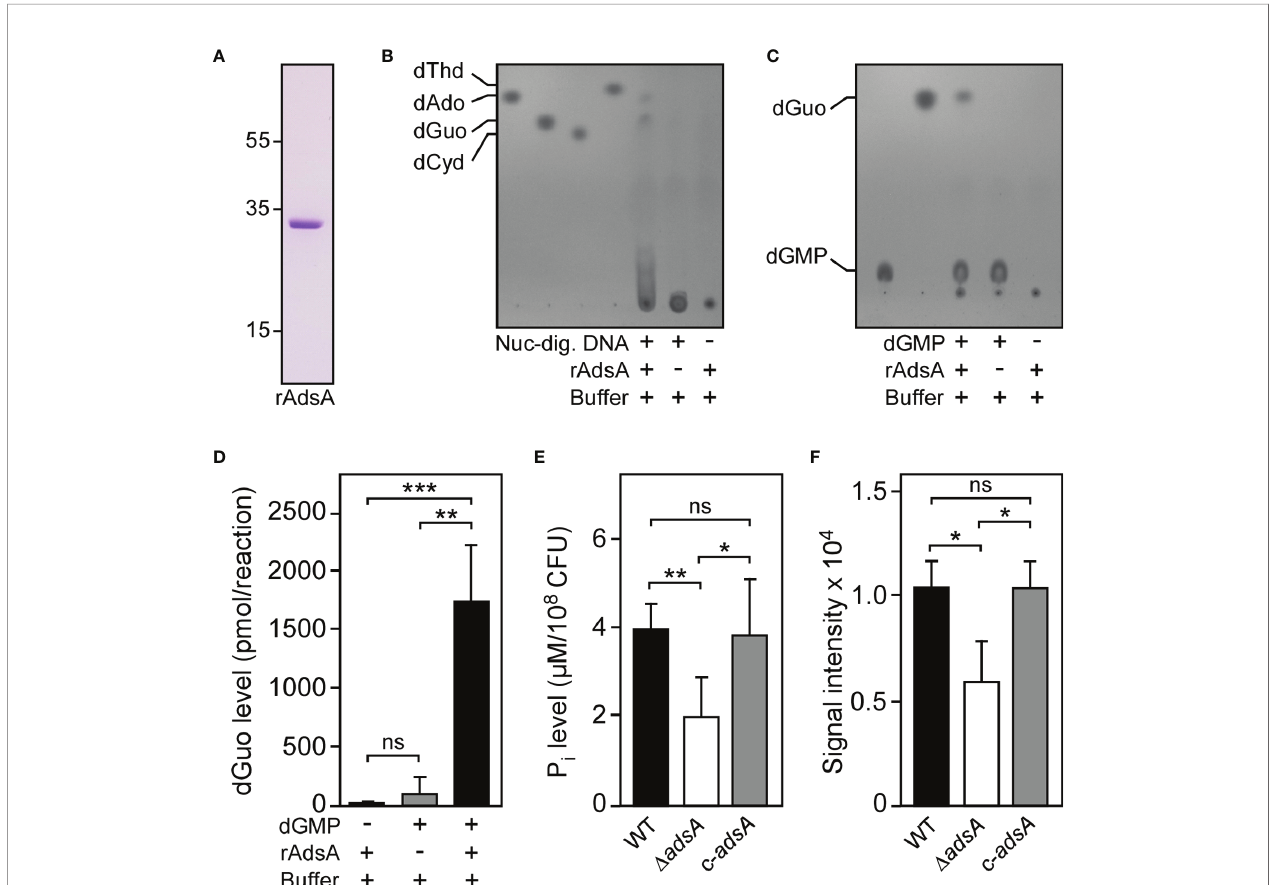
FIGURE 1 | S. aureus deploys AdsA to synthesize deoxyguanosine. (A) SDS-PAGE analysis of puri fi ed rAdsA. Numbers to the left of the SDS-PAGE indicate the migration of molecular weight markers in kilodaltons. (B, C) Detection of dGuo formation by rAdsA. rAdsA was incubated with Nuc-digested DNA (B) or dGMP (C) at 37°C. Controls lacking Nuc-digested DNA, dGMP, or rAdsA are indicated (+ and – symbols). Reaction products and the formation of dGuo were analyzed via TLC. The migratory positions of single deoxyribonucleosides or dGMP were identi fi ed using pure standards. Representative images are shown. (D) Detection and quanti fi cation of rAdsA-derived dGuo by LC-MS/MS. rAdsA was incubated with dGMP at 37°C. Controls lacking dGMP or rAdsA are indicated (+ and – symbols). Reaction products and the formation of dGuo were analyzed and quanti fi ed via LC-MS/MS. (E) S. aureus -dependent hydrolysis of dGMP. The ability of S. aureus to hydrolyze dGMP in an AdsA-dependent manner was evaluated by assessing the release of inorganic phosphate (P i ) using a malachite green-based colorimetric assay. Wild-type S. aureus Newman (WT) or the mutant lacking adsA ( D adsA ) along with the complemented adsA variant (c- adsA ) are indicated. (F) Analysis and quanti fi cation of S. aureus -dependent formation of dGuo. Lysostaphin-generated cell wall extracts of indicated strains were incubated with dGMP at 37°C and analyzed via TLC as described above. Individual dGuo spots of independent replicates were quanti fi ed by using ImageJ. Data are the mean (± standard deviation [SD]) values from at least three independent determinations. Statistically signi fi cant differences were analyzed with one-way analysis of variance (ANOVA) and Tukey ’ s multiple-comparison test (D – F) ; ns, not signi fi cant ( P ≥ 0.05); * P < 0.05; ** P < 0.01; *** P <